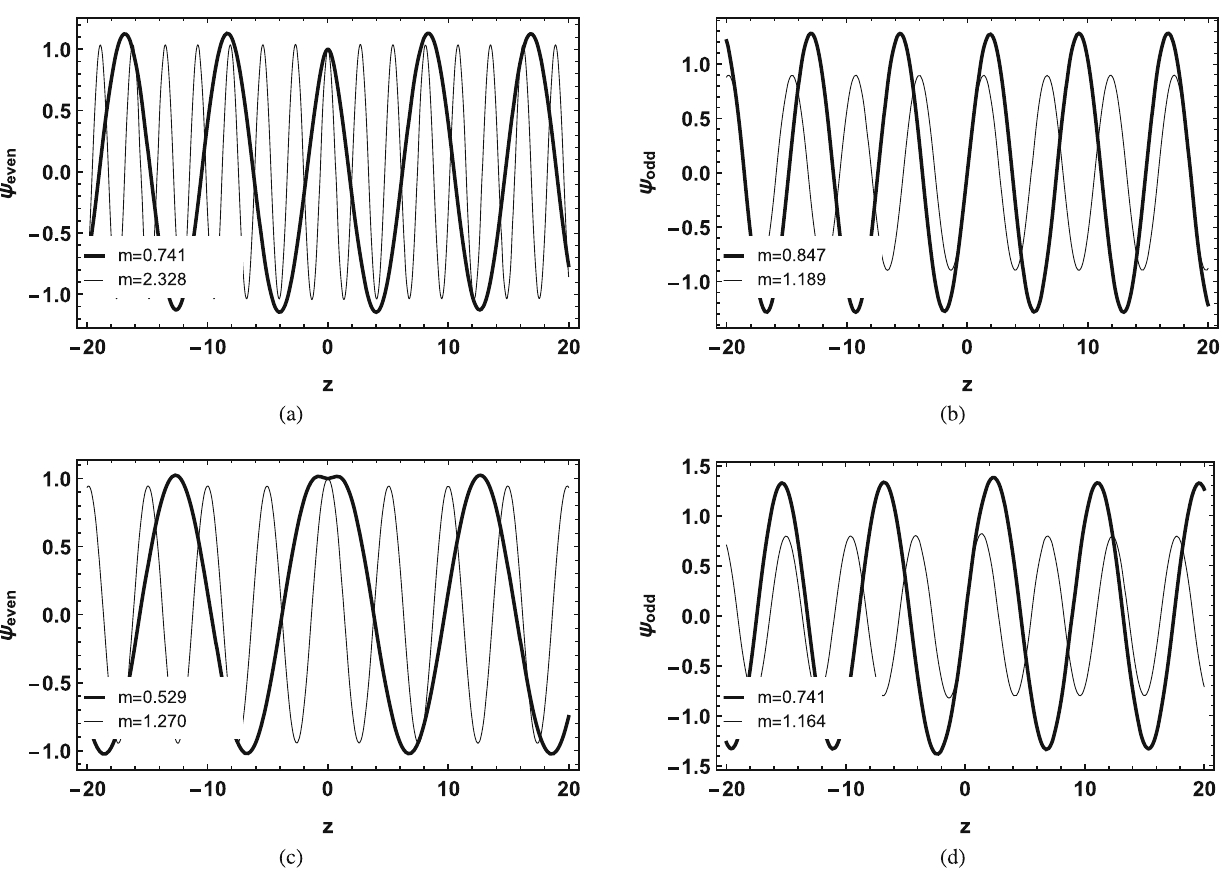
Fig. 6 The behavior of massive modes for G 1 (φ) , with n = 1 and b = 2 and p = λ = 1. To the Gauge field, a ψ e v en b ψ odd . KR field, c ψ e v en . d ψ